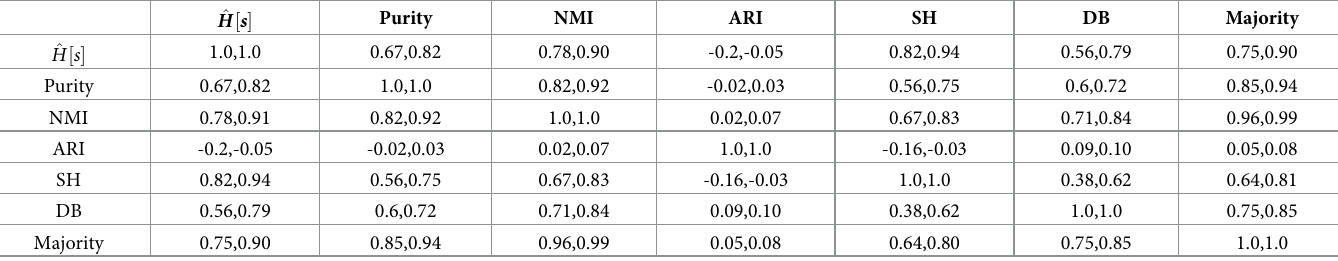
Datasets : Here we consider the synthetic and the protein datasets where the ground truth clus- ter size distributions are skewed. Table 4. Kendall’s τ and Spearman’s correlation result for Crime